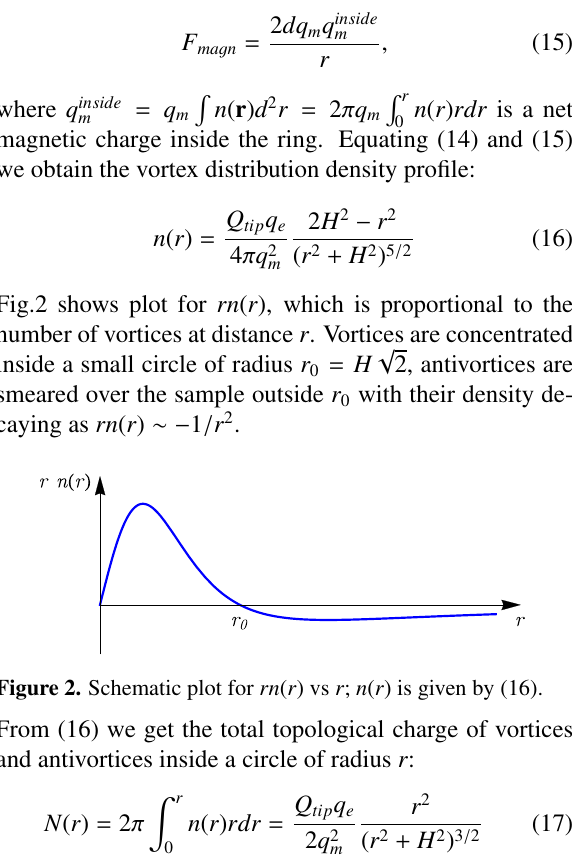
Figure 1. Geometry of the system. Sample is a disk with radius R and thickness h . Above its center at the height H the tip of the